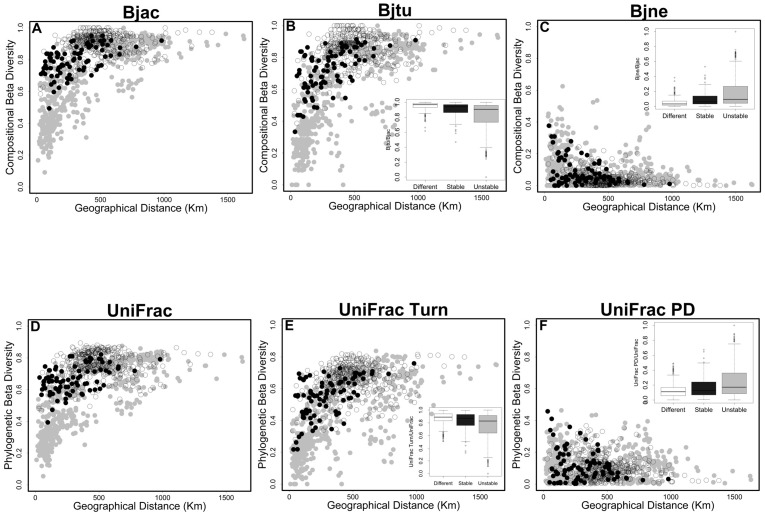
Relationships between geographical distance and Compositional Beta Diversity (CBD, A = βjac, B = βjtu and C = βjne) and Phylogenetic Beta Diversity (PBD, D = UniFracTotal, E = UniFracTurn and F = UniFracPD) components.Subplots are showing the proportion explained by turnover (βjtu/βjac and UniFracTurn/UniFracTotal) and nestedness (βjne/βjac and UniFracPD/UniFracTotal) components. Symbol colors indicate the region where the sites occur in the southern range of Brazilian Atlantic Forest. Black circles indicate dissimilarity between sites within stable region (Quaternary Climatic Stability). Gray circles indicate dissimilarity between sites within unstable region (Quaternary Climatic Oscillations). White circles indicate dissimilarity between unstable and stable sites (different regions).